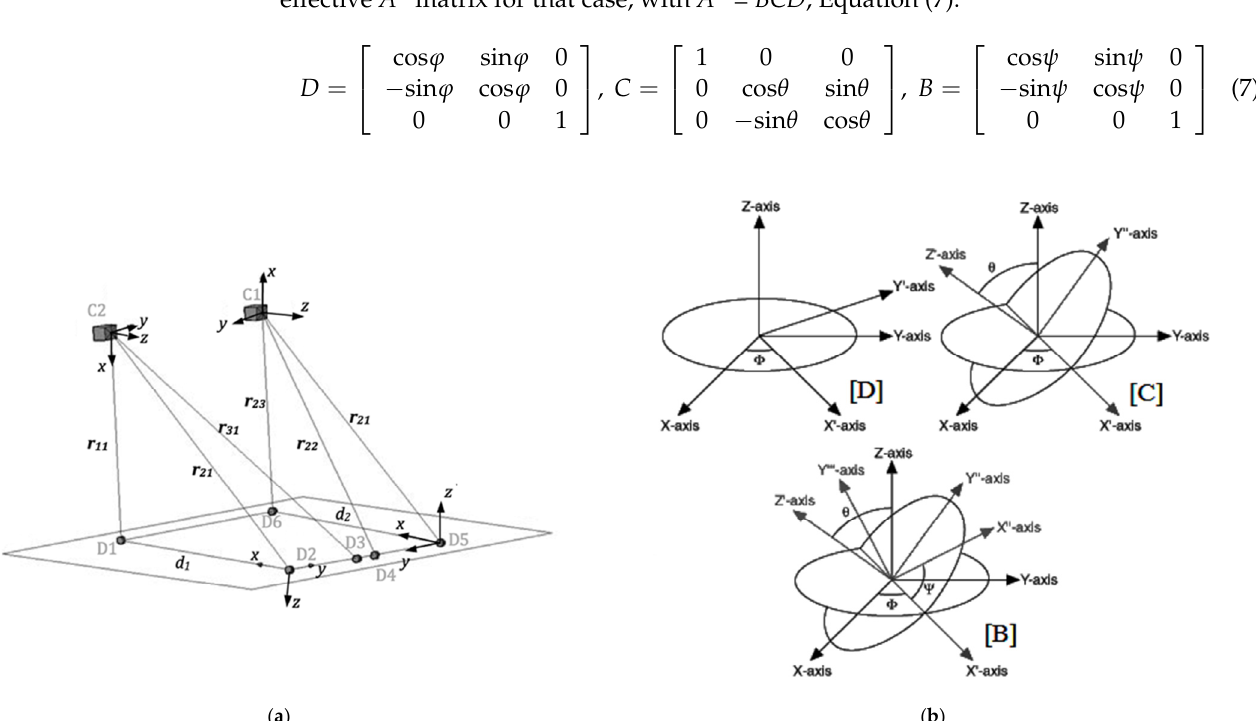
Figure 4. Details of trilateration method used to measure z displacement of each cell relative to cab base: ( a ) Triaxial force transducers (load cells, C1 and C2) with linear displacement transducers (D1–D6) connected; ( b ) Coordinate rotation with the Euler angles, where [D] rotation about Z-axis by 𝜑 , [C] rotation about X ′ -axis by 𝜃 , [B] rotation about Z ′ -axis by 𝜓 .